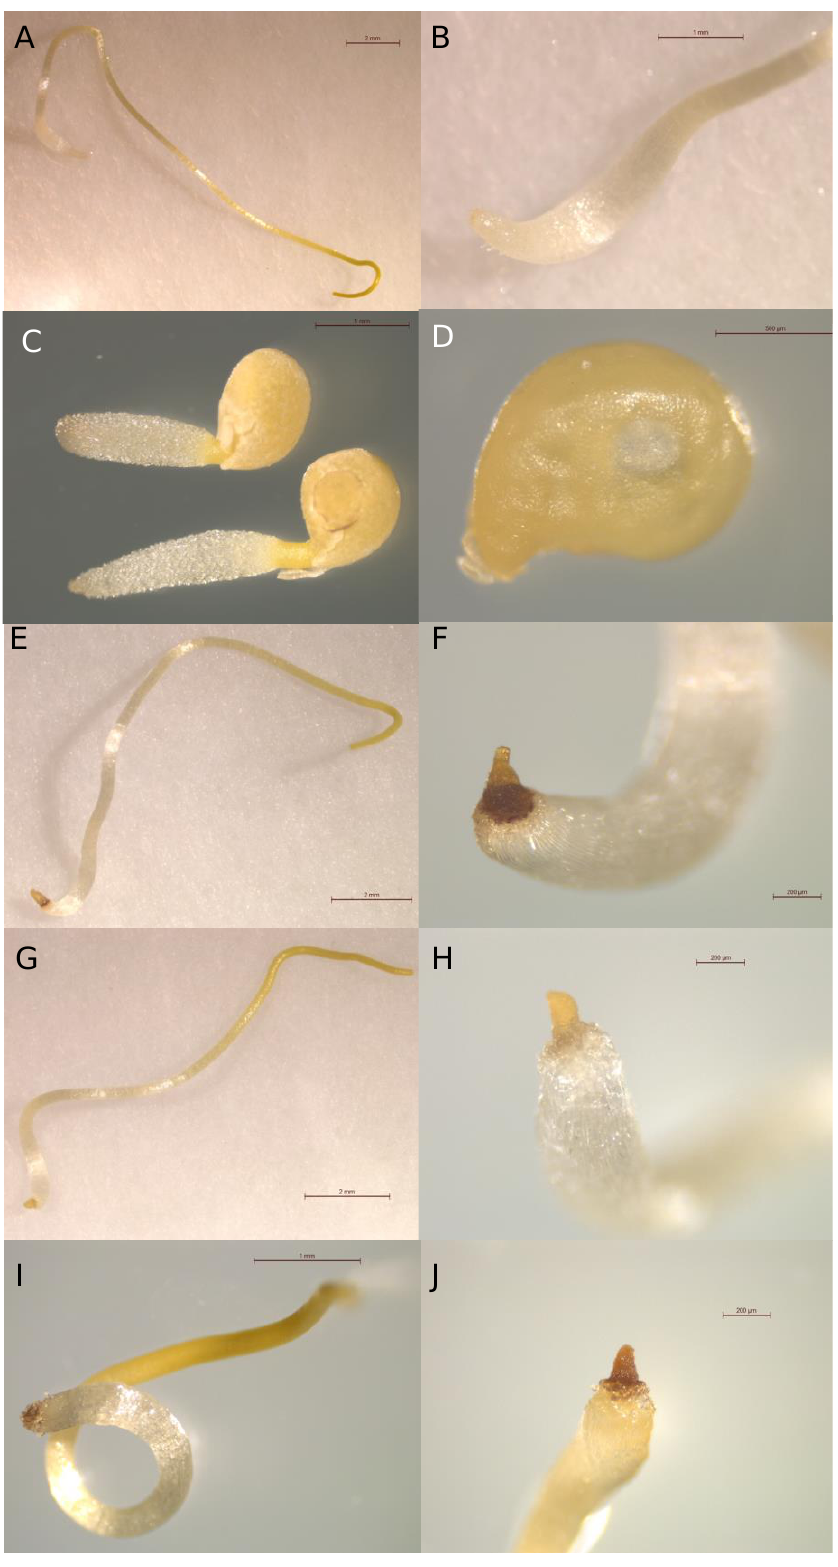
Figure 4. Photographs showing a Cuscuta seedling treated with control ( A , B ); hydrocinnamic acid ( 1 ) 1 mM ( C ); 3-(4-fluorophenyl)propionic acid ( 13 ) ( D ); 3,4-dihydroxyhydrocinnamic acid ( 17 ) ( E , F ); 3-(3-hydroxy-4-methoxyphenyl)propionic acid ( 18 ) ( G , H ); 3-(4-aminophenyl)propionic acid ( 12 ) ( I , J ).